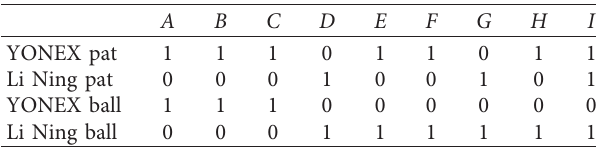
Table 1: Item-user matrix.